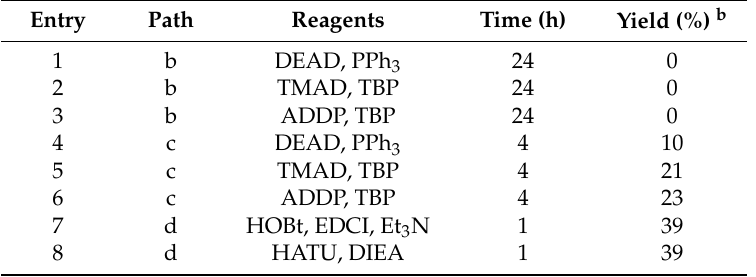
Table 2. Results of macrocyclization by Mitsunobu reactions and amide formation a